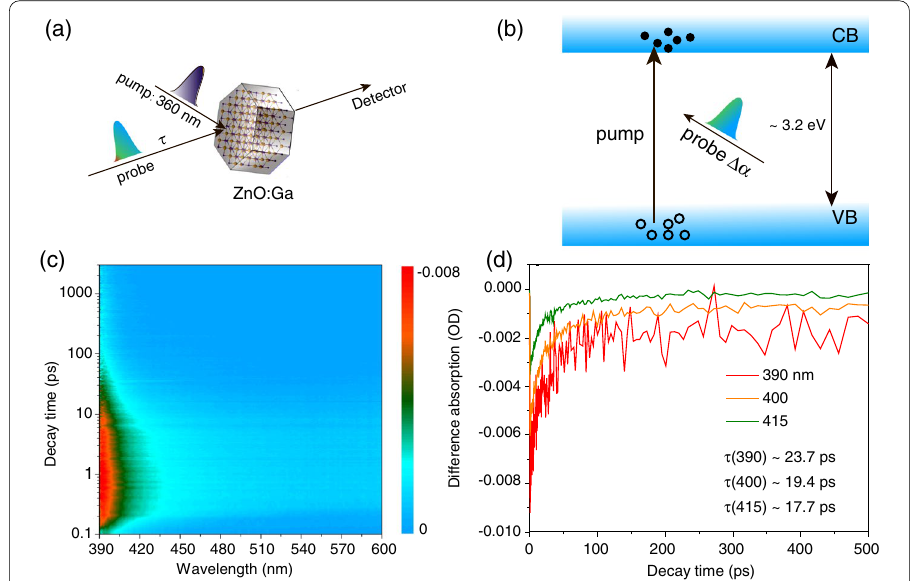
Fig. 3 TA spectrum of ZnO:Ga single crystal. a Schematic diagram of transient absorption spectroscopy. b Energy band structure diagram of ZnO:Ga single crystal. c Color plot of femtosecond TA spectrum. d TA spectra of ZnO:Ga single crystal at different wavelengths (390, 400, 415